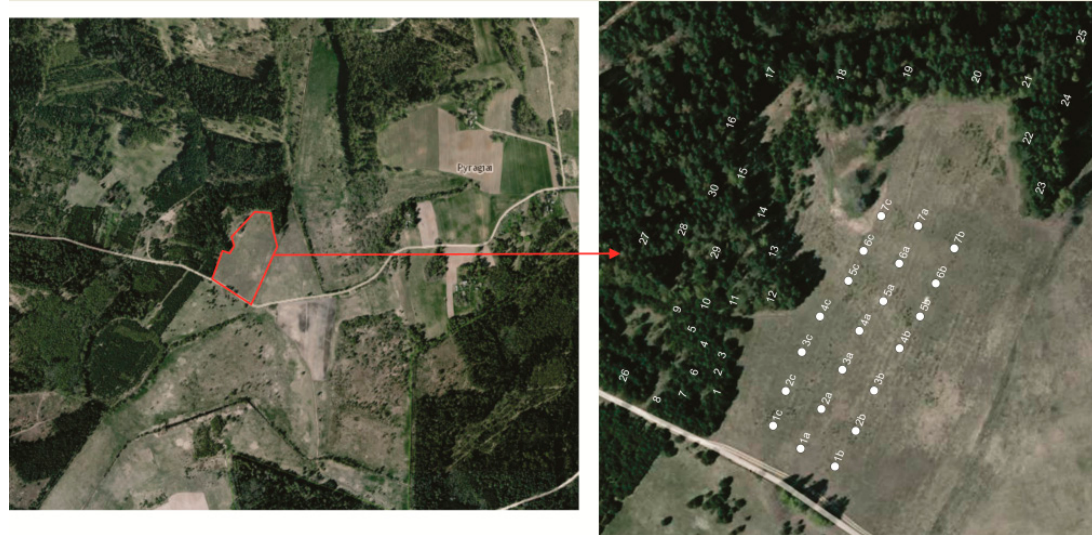
Figure 1. Sampling scheme in a self-regenerating Scots pine/silver birch stand (light grey area) and in a surrounding putatively maternal mixed Scots pine-silver birch stand (dark green area). White dots labelled with numbers from 1a to 7a show seven circular sampling plots in a regenerating site, while dots labelled with numbers from 1b to 7b and 1c to 7c show additional Scots pine seedling sampling locations. Numbers not associated with dots (1–30) indicate locations of sampled putative maternal (seed) trees in the surrounding stand.